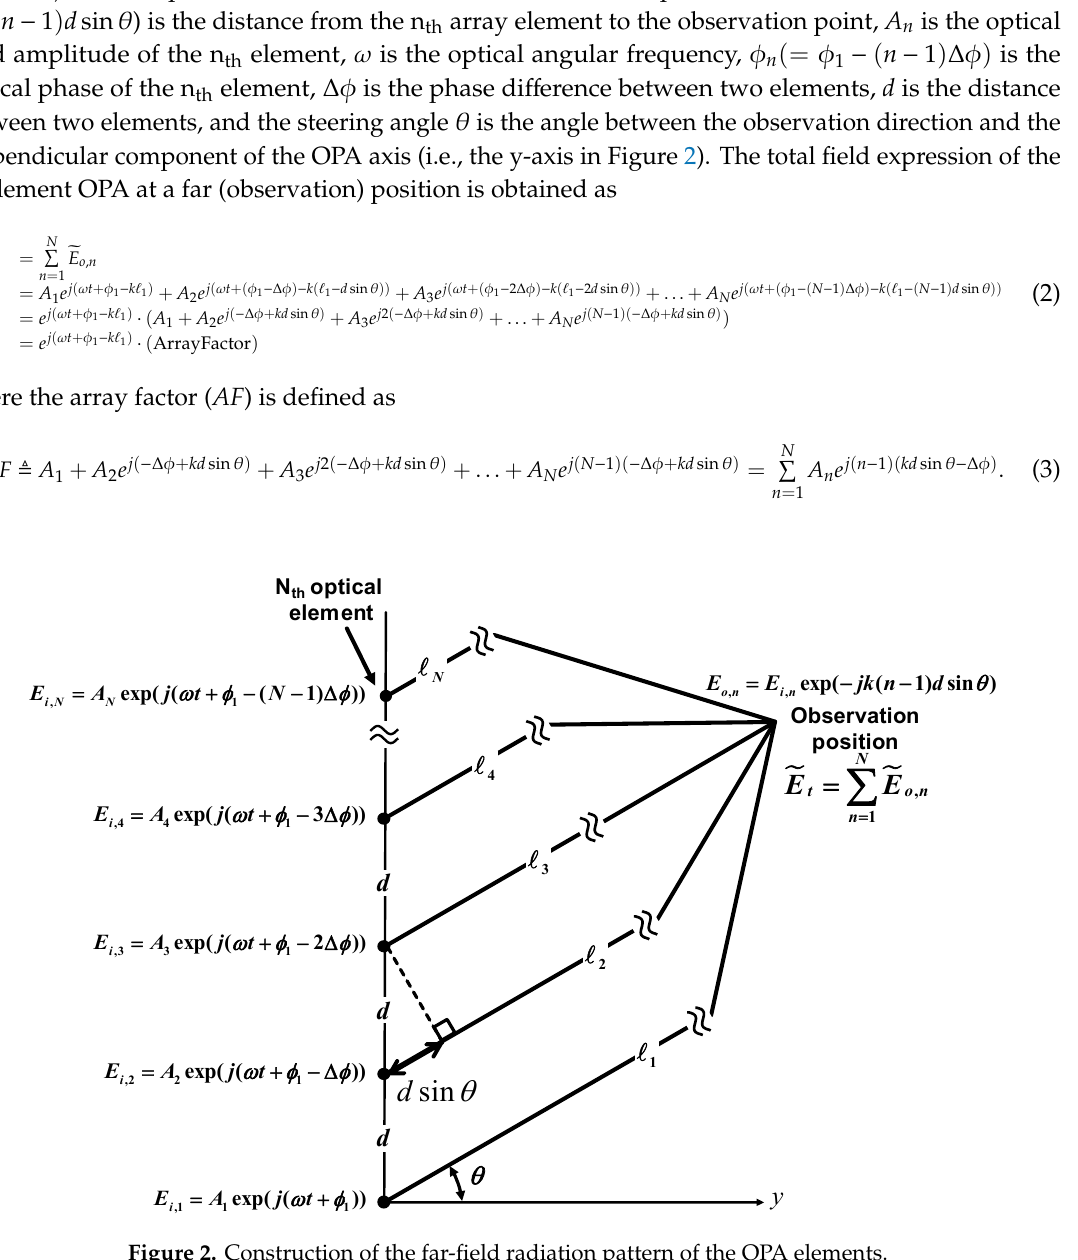
Figure 2. Construction of the far ‐ field radiation pattern of the OPA elements.